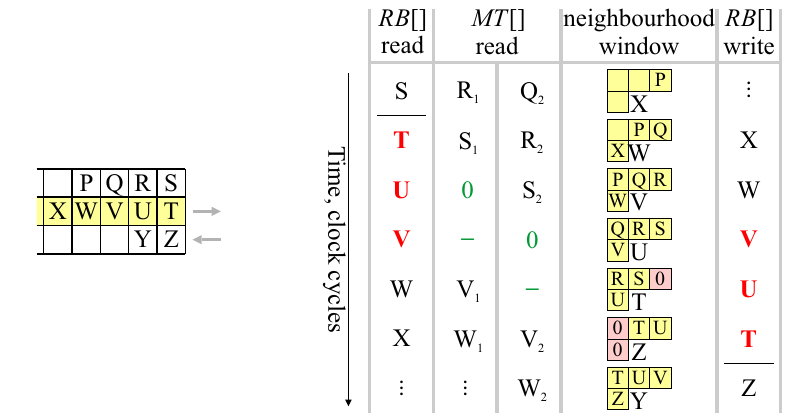
Figure 13. End of row timing, showing data hazards in red. Subscripts 1 and 2 refer to the first and second reads from the merger table (if